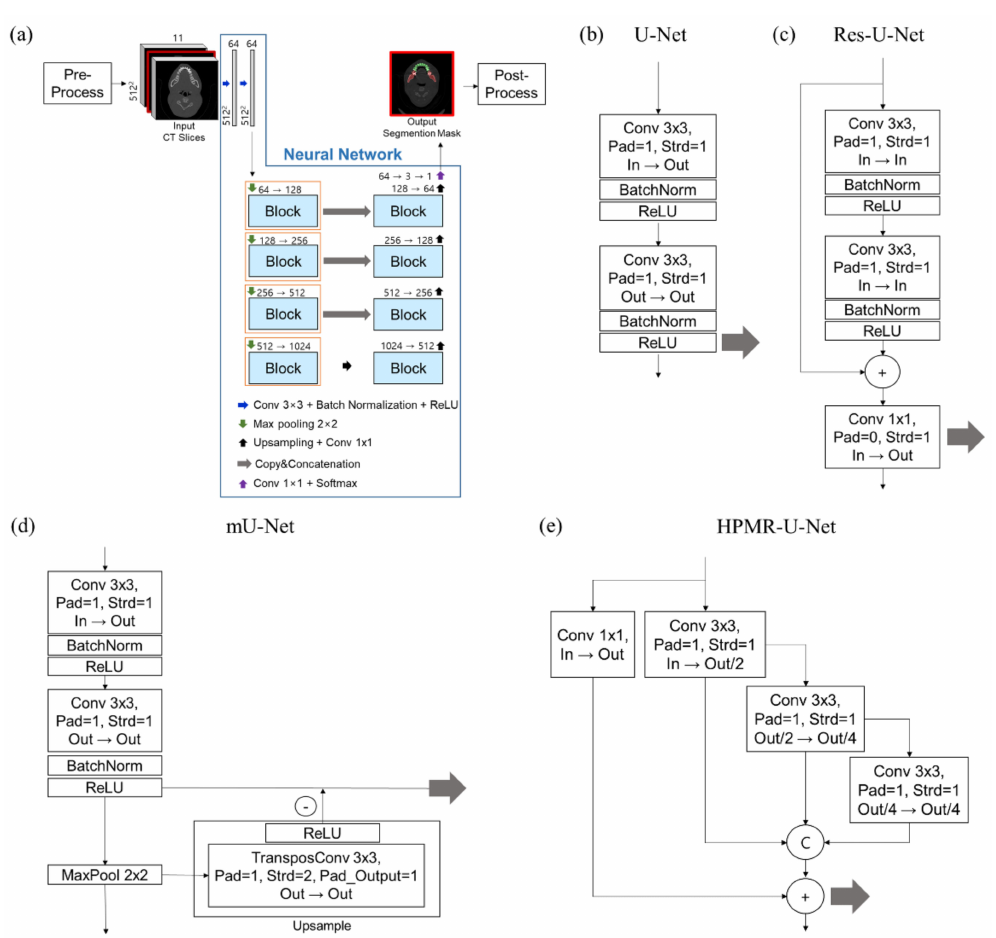
Figure 4. Overall framework and block architectures of neural networks. ( a ) Overall framework. The numbers above the boxes refer to the channel number of the feature maps. The orange boxes for each neural network are represented in ( b – e ), with ( b ) block architecture of U-Net, ( c ) block architecture of Res-U-Net, ( d ) block architecture of mU-Net, and ( e ) block architecture of